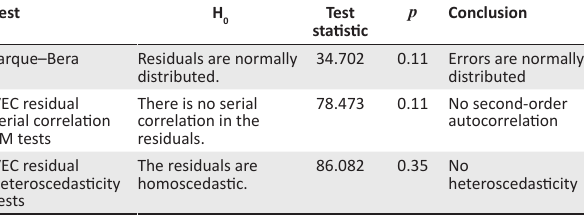
FIGURE 3: Inverse roots of AR characteristic TABLE 5: Other diagnostic tests.